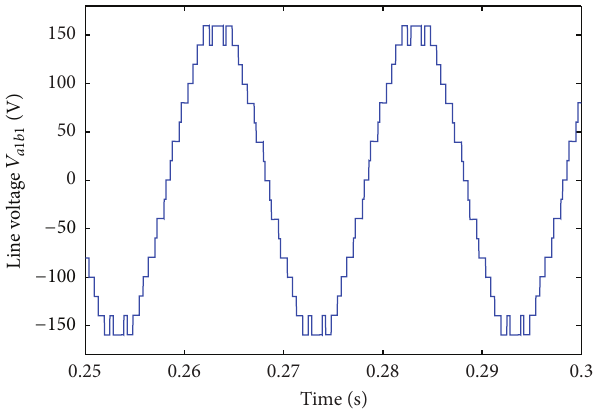
Figure 10: The converter’s output line-voltage 𝑉 𝑎